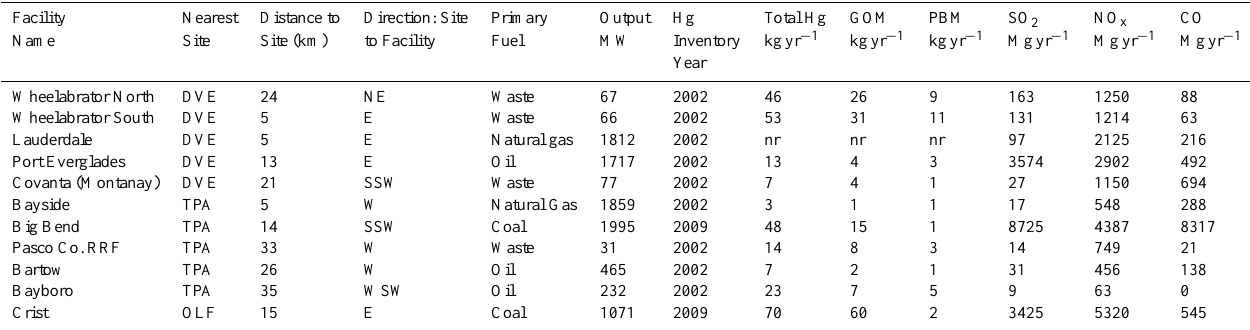
Table 1. General location and emission inventory data for EGPs within a 50 km radius of each site. The 2002 Hg data is from the EPA NEI inventory and the 2009 Hg data is from an estimate provided from the Florida Department of Environmental Protection using US EPA CAMD hourly heat input data and EPRI correlation coefficients for percent